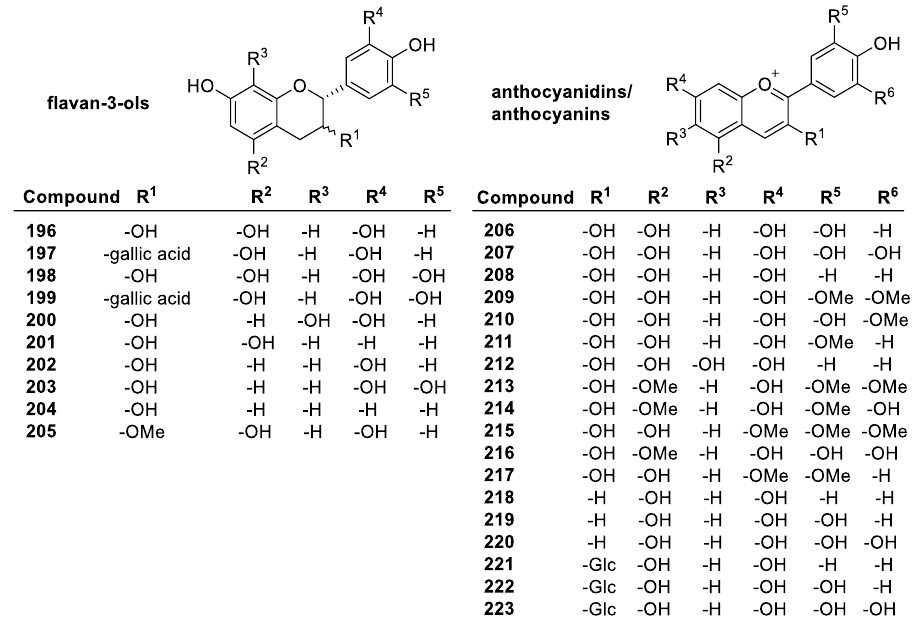
Figure 12. Representative examples of flavanones and flavanonols with antioxidant effect.